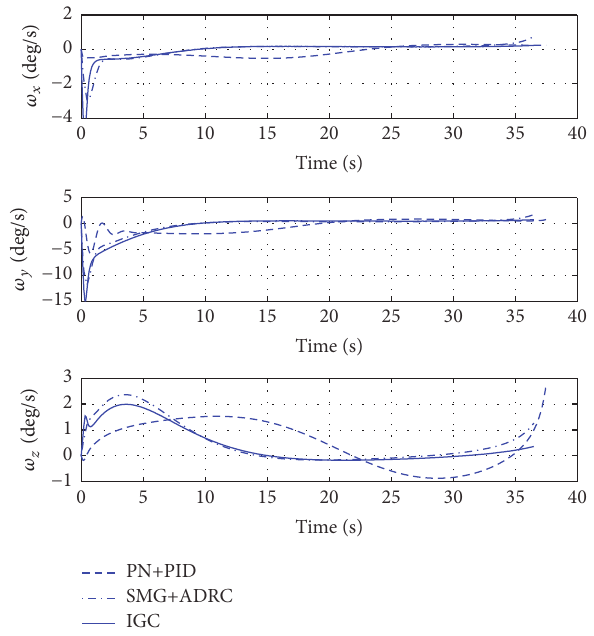
Figure 5: The range of rotational angular velocity with respect to time in Scenario